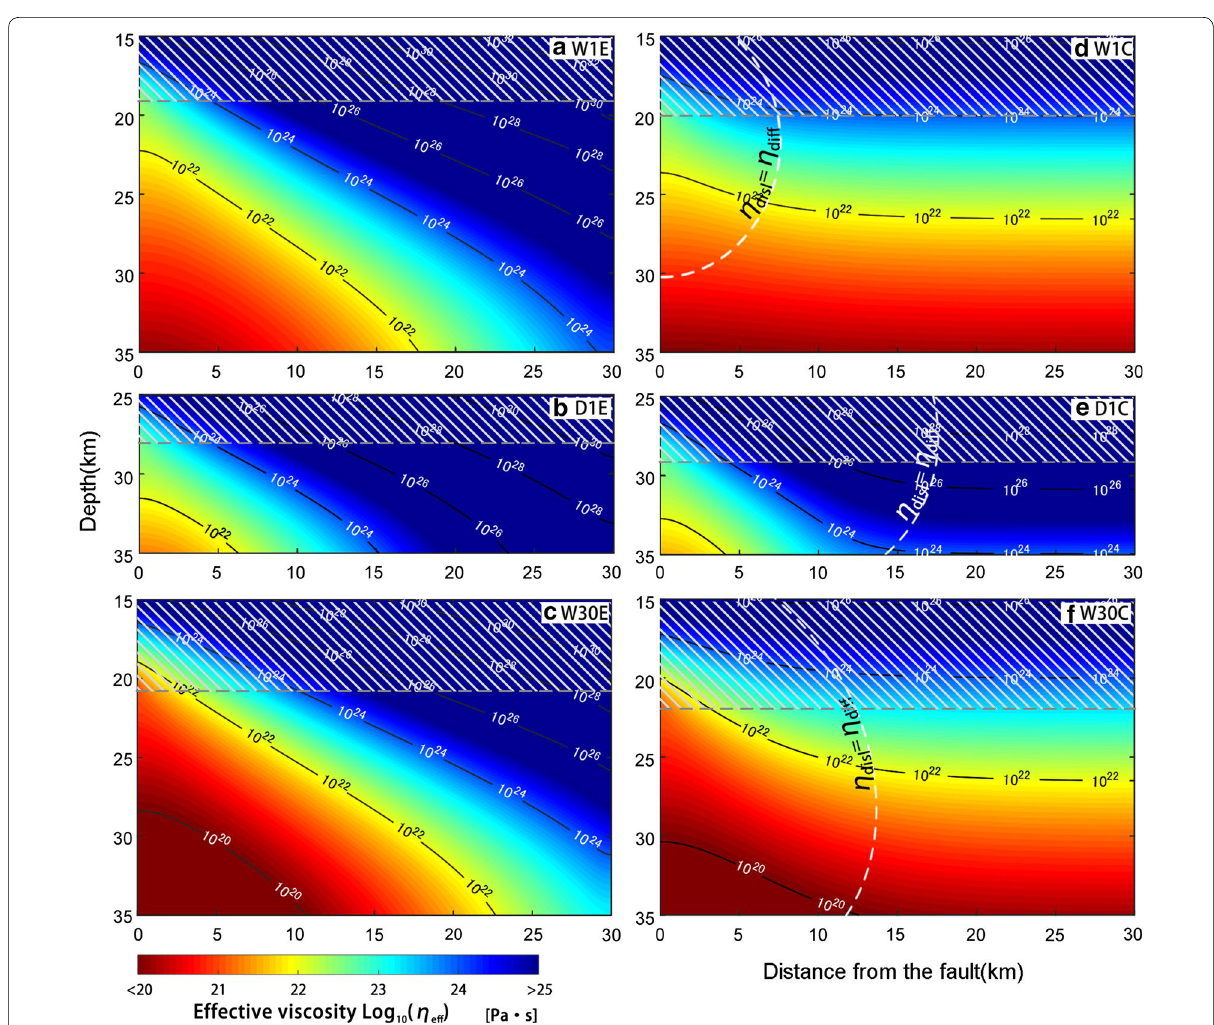
Fig. 8 Effective viscosity versus depth and distance from the fault for equilibrium grain size ( a – c ) and constant grain size ( d – f ). The white broken line in d – f indicates the location in which diffusion creep and dislocation creep have the same slip